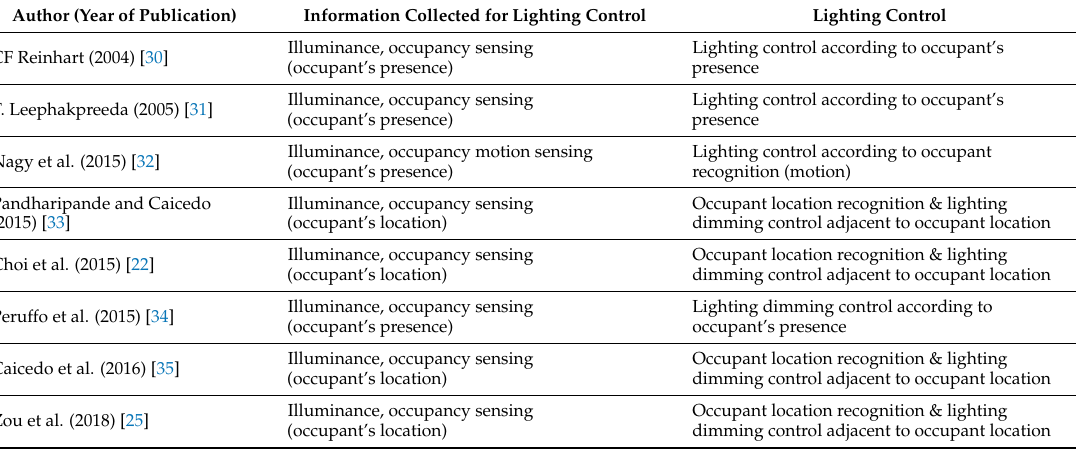
Table 3. Consideration of previous studies related to lighting